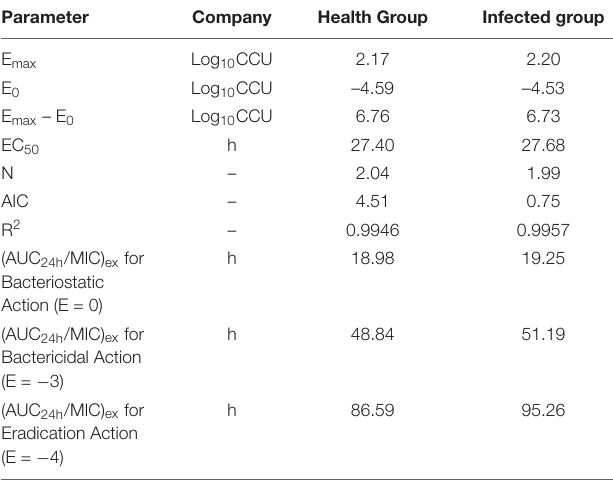
TABLE 4 | The results of ex vivo PK-PD modeling.